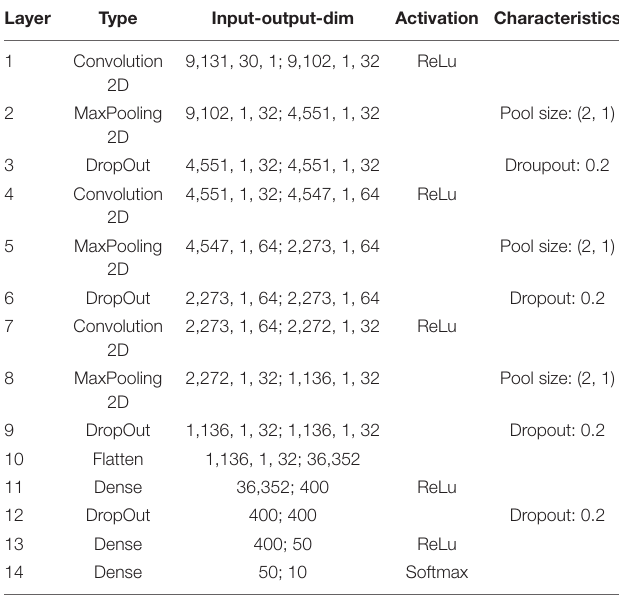
TABLE 2 | Exact parameters of the used deep convolutional network (FSDD data set).